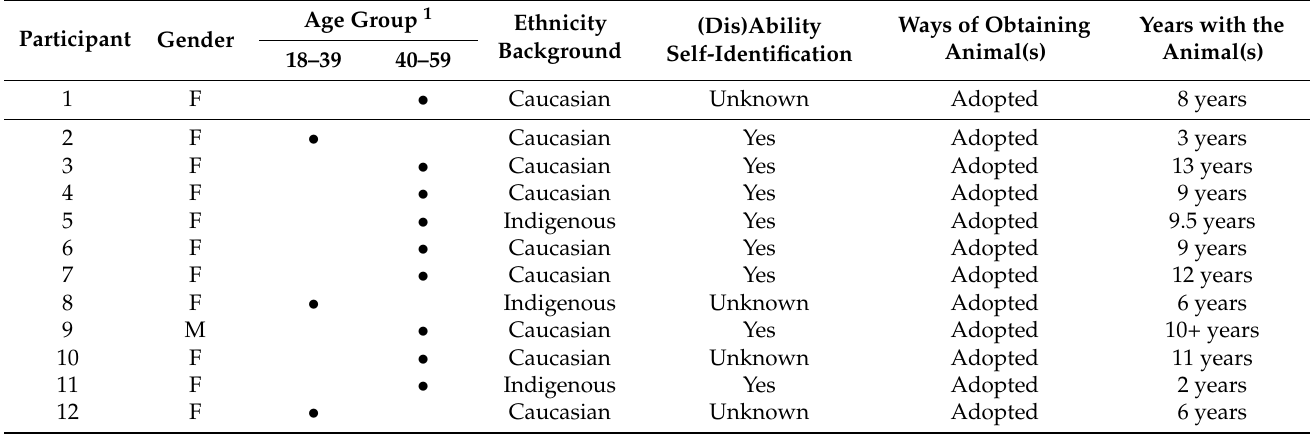
Table 1. Participants’ demographic